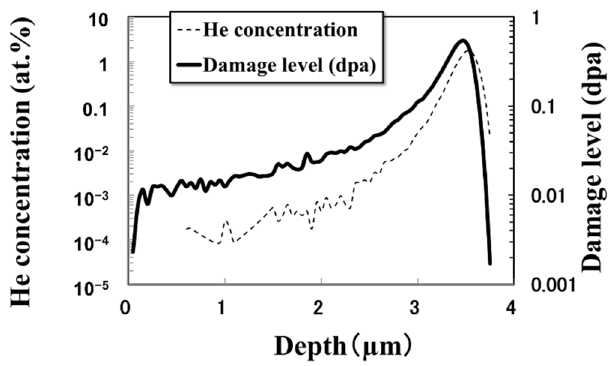
Figure 1. Calculation results of an ion range profile of implanted He ion and a vacancy concentration profile in V, obtained by 2-MeV He + -ion irradiation.